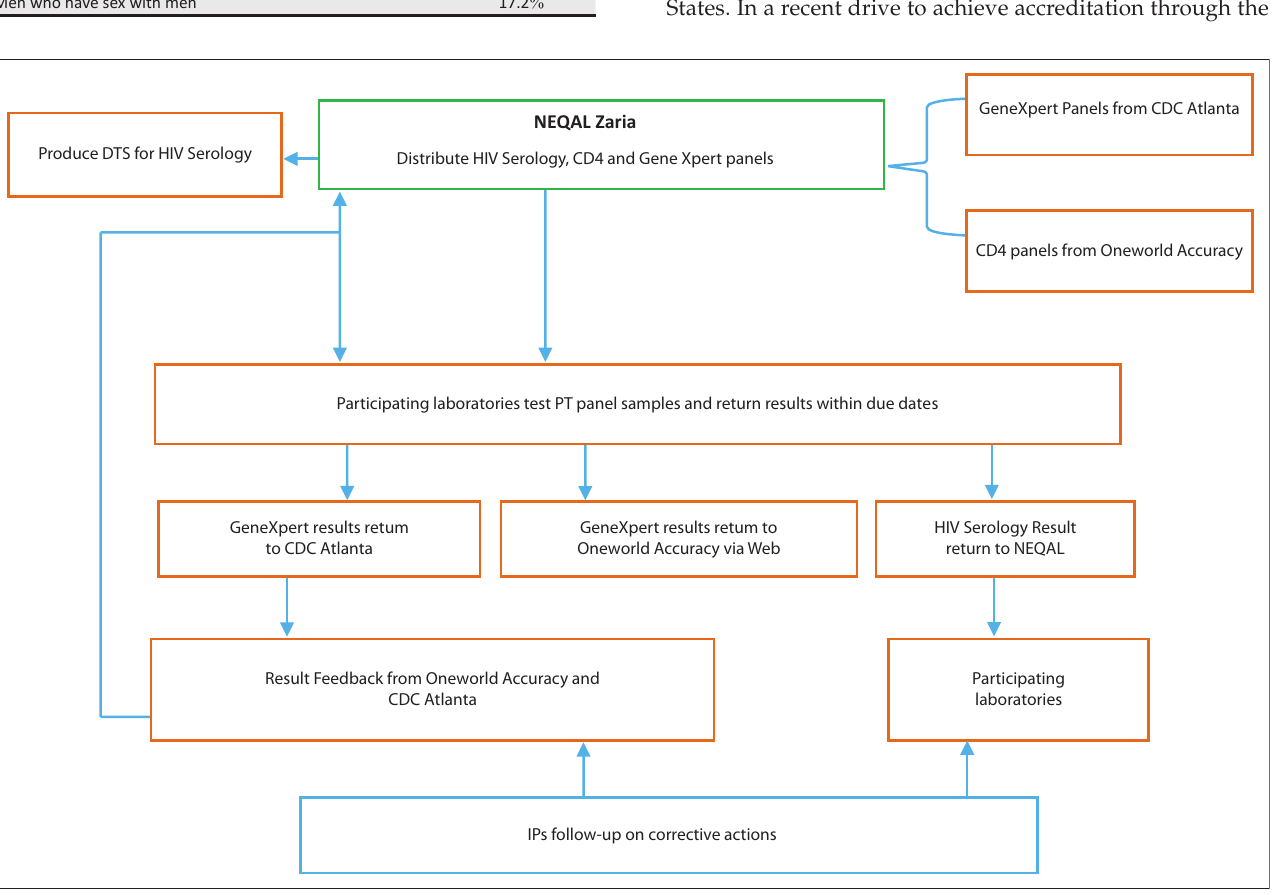
FIGURE 2: Nigeria national external quality assessment structure.